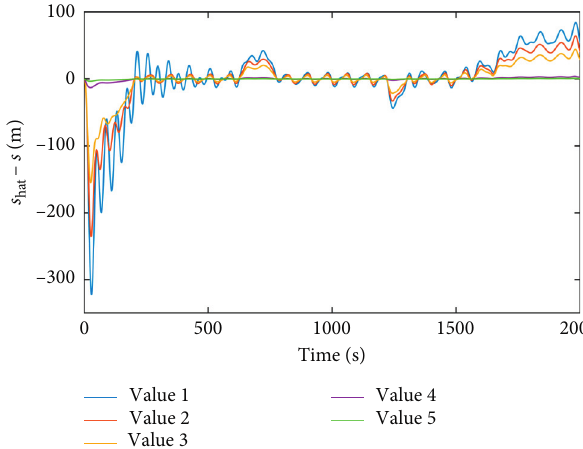
Figure 5: Position observer estimation error of the